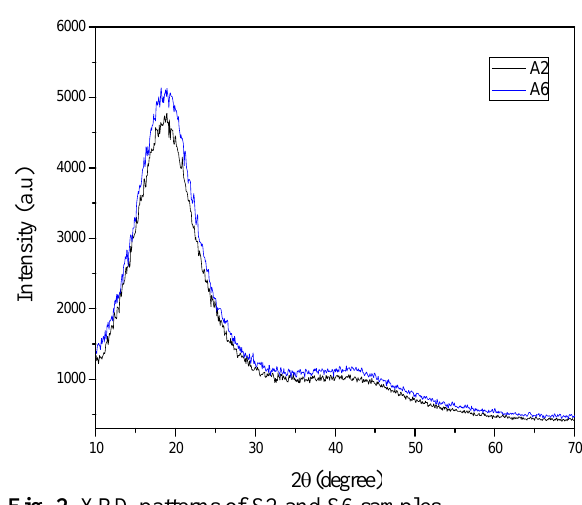
Fig. 2 . XRD patterns of S2 and S6 samples.